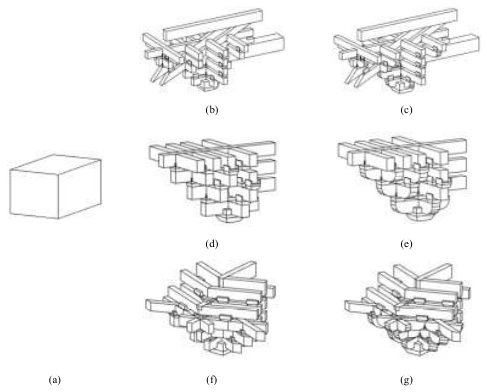
Figure 2. Multi-LoD models for Dou-Gong: (a) LoD100; (b) LoD200 for Zhutou Puzuo; (c) LoD300 for Zhutou Puzuo; (d) LoD200 for Bujian Puzuo; (e) LoD300 for Bujian Puzuo; (f) LoD200 for Zhuanjiao Puzuo; (g) LoD300 for Zhuanjiao Puzuo.